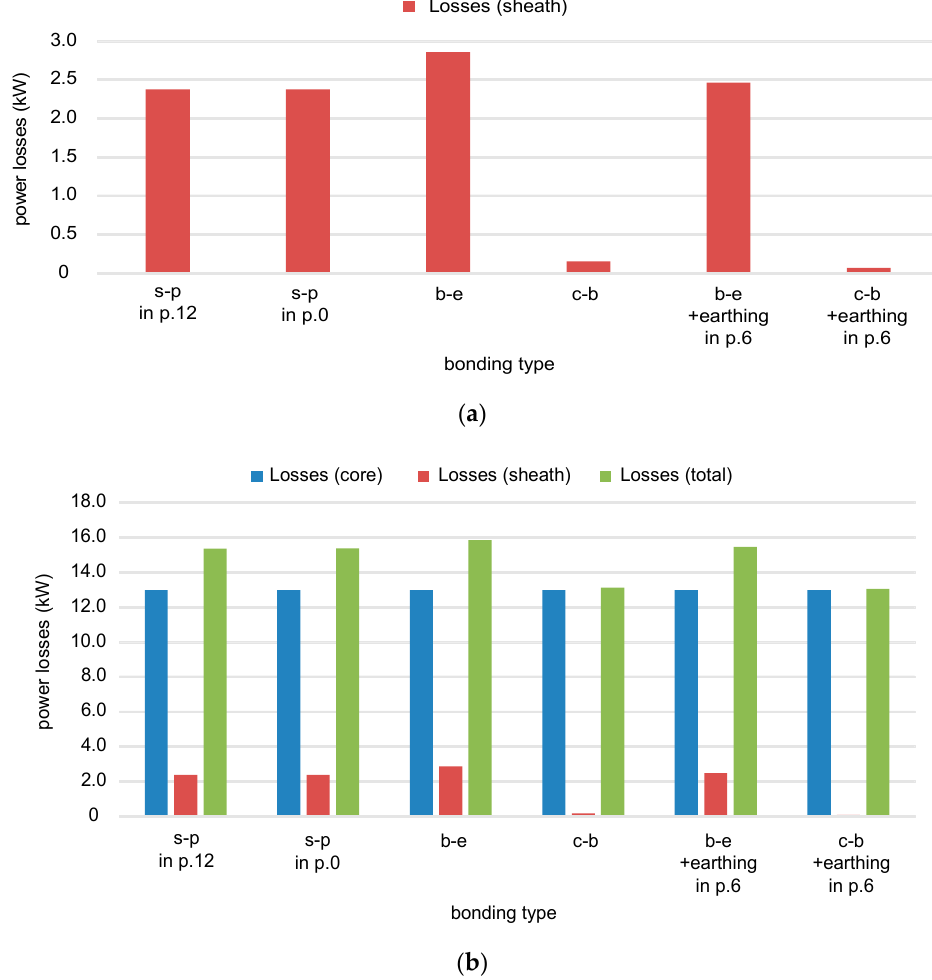
Figure 12. Power losses in the analyzed three-phase cable system for the transferred power 10 MW, tg φ = 0.4: ( a ) losses in the metallic sheaths; ( b ) comparison of the losses in the metallic sheaths, cores and total losses; s-p: single-point bonding; b-e: both-ends bonding; c-b: cross bonding.